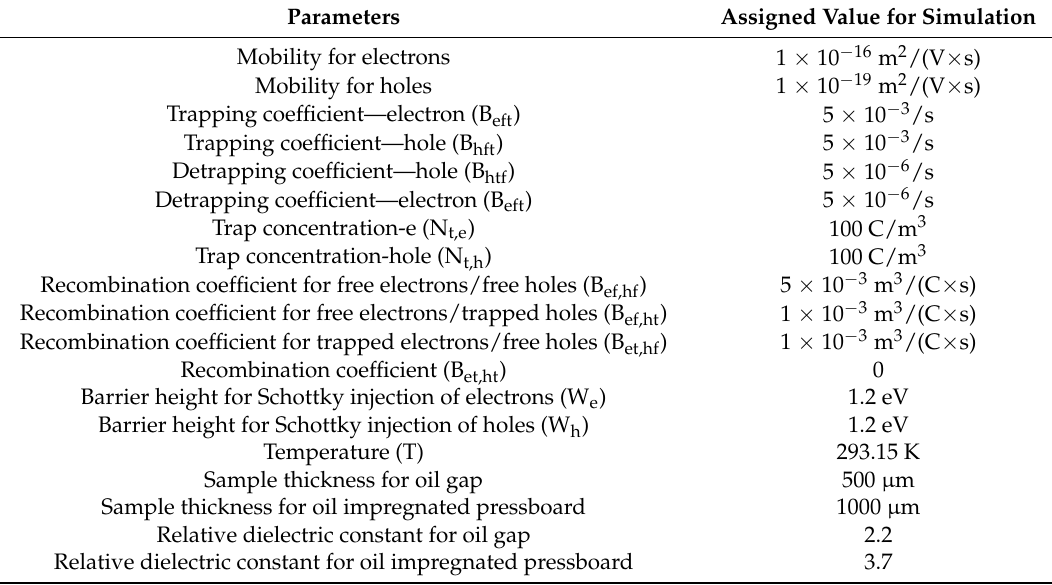
Table 1. Parameters for